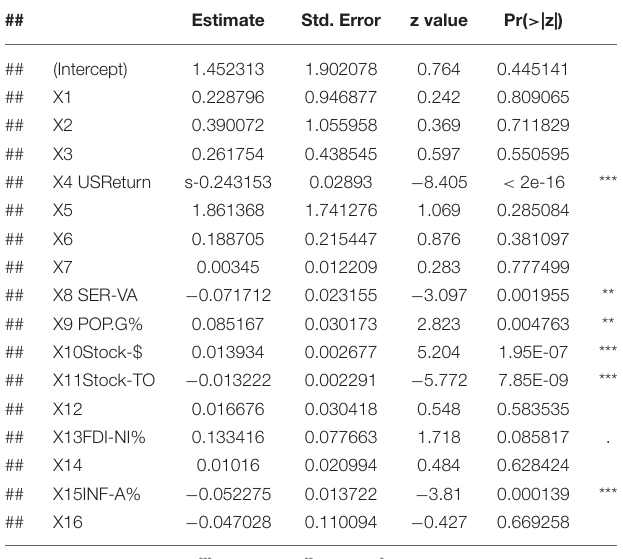
TABLE 5 | Logistic regression coefficient estimates the pooled test data ( N = 1022; 50% of the training set